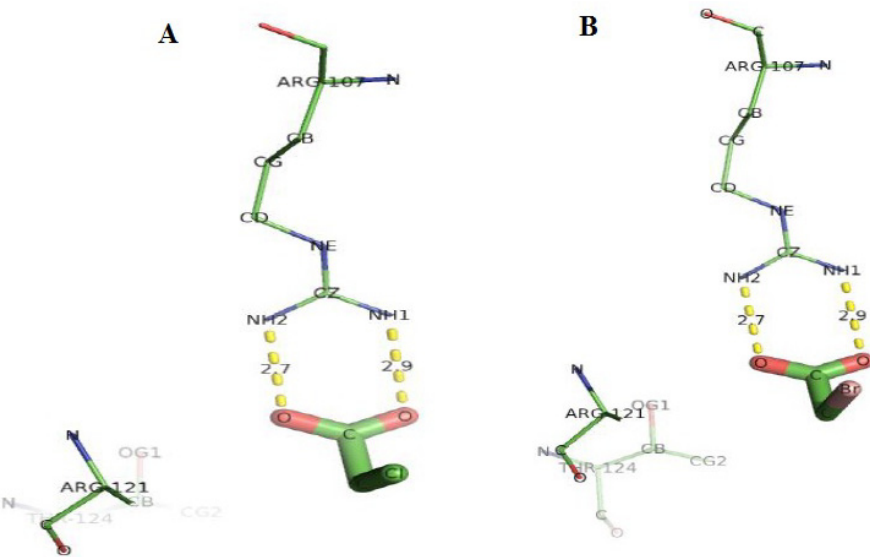
Figure 19. The interacting residues of DehD with ( A ) MCA ( B ) MBA. Hydrogen bond distances are in